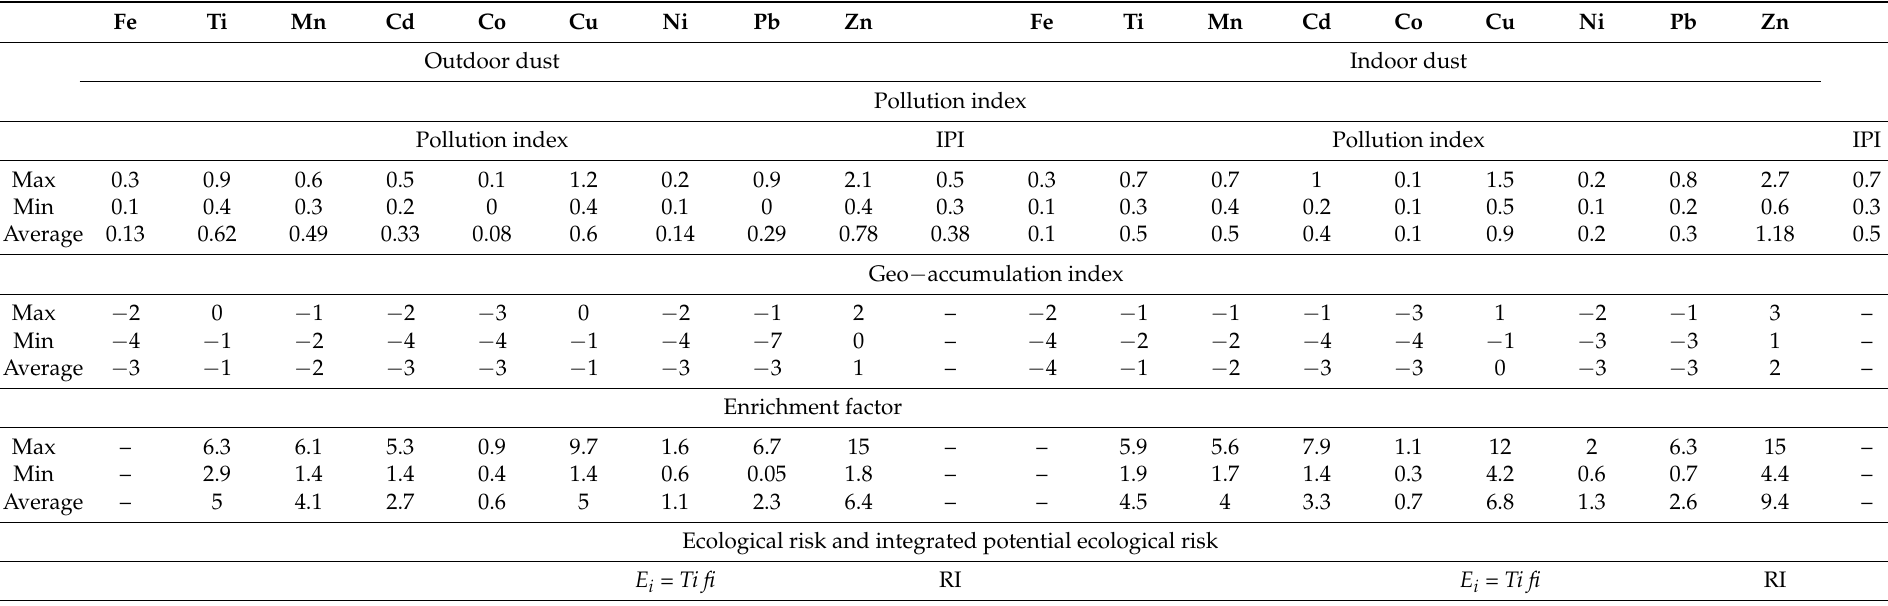
Table 2. The calculated data of the pollution index (PI), integrated pollution index (IPI), geoaccumulation index (I geo ), enrichment factor (EF), monomial